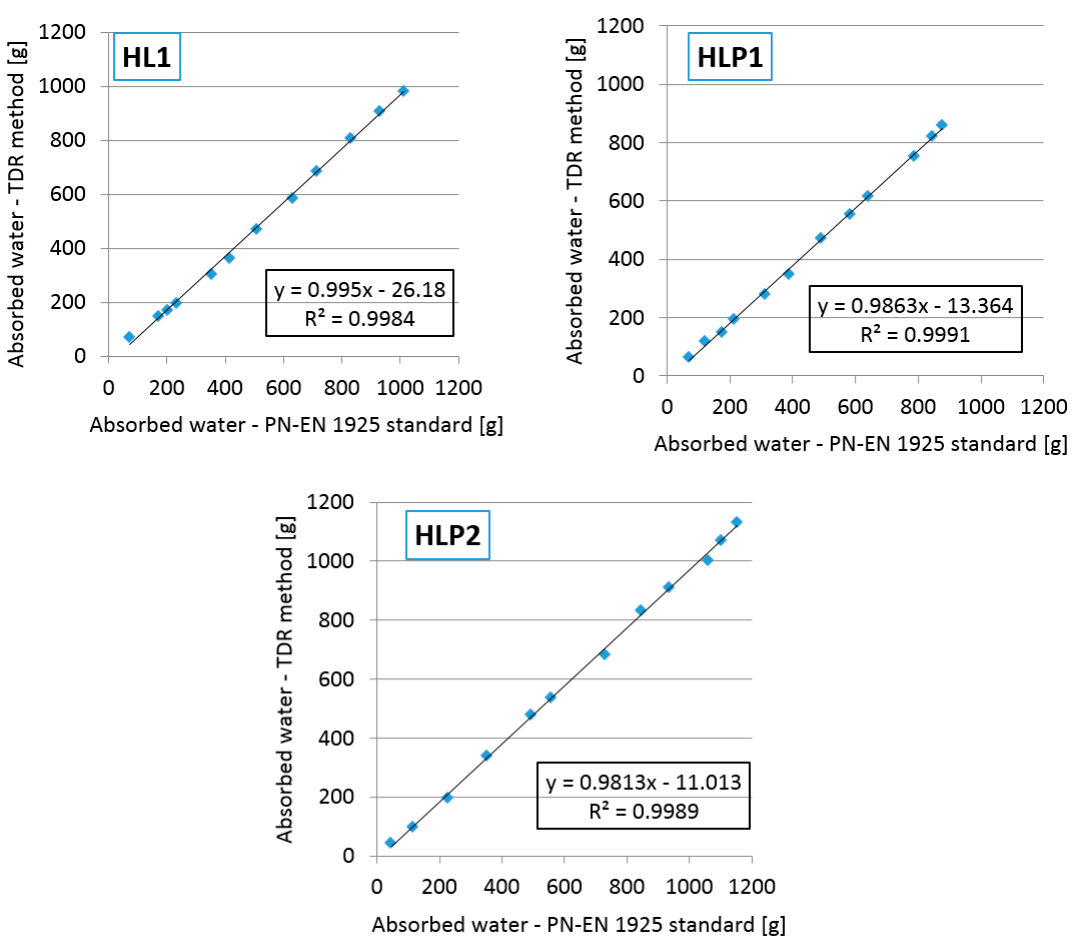
Figure 15. Correlations between the amount of absorbed water evaluated using the gravimetric method and the reflectometric one.